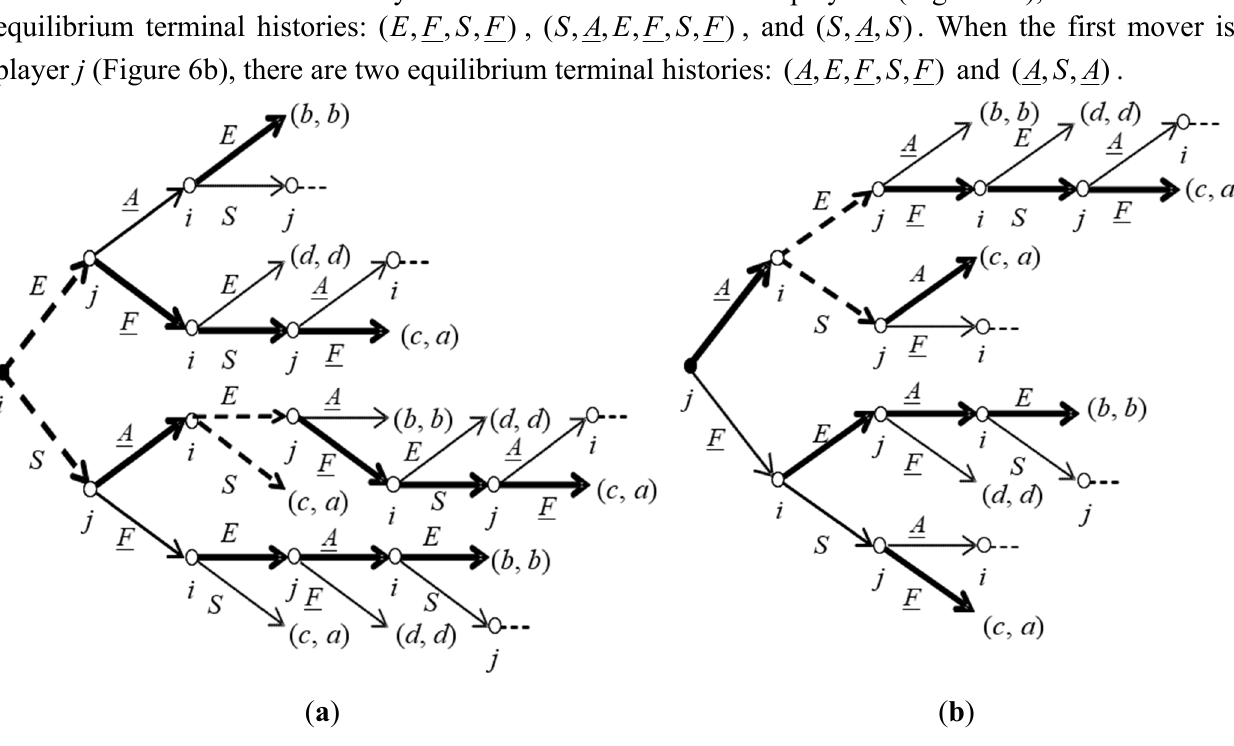
Figure 6. CP ( G ), G being the original game in Figure 5, with i ( a ) or j ( b ) as first mover. and , player i gets a payoff equal to c